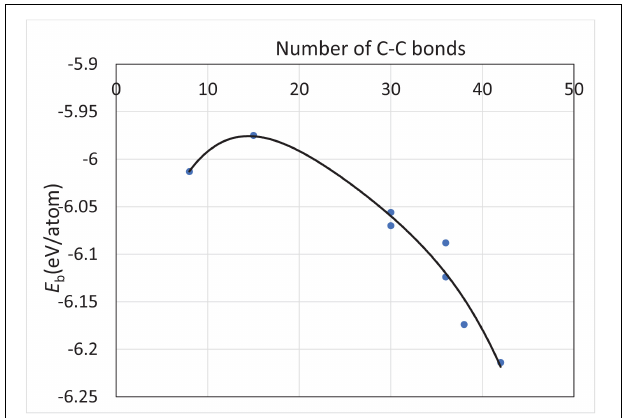
FIGURE 4 | The trend of the binding energy of unpassivated structures with respect to the number of C–C bonds in the structures from Figure 2 . The solid line is a polynomial fit of the calculated binding energies represented by the solid circular dots. Except for the two least stable structures on the top-left corner of the plot, all the structures follow the trend that the stability of a structure increases as the number of C–C bonds increases in that structure.